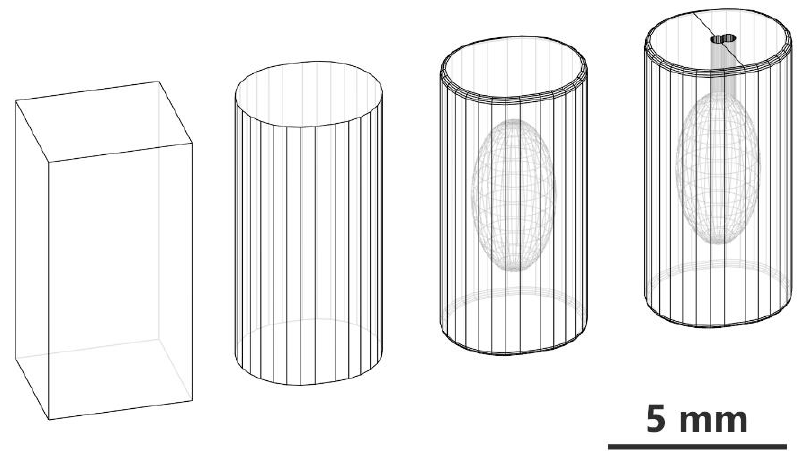
Figure 4. Designing artificial spinal cords using Blender. Starting with key dimensions, add details and curvature, then remove internal cavities and channels with boolean subtraction.